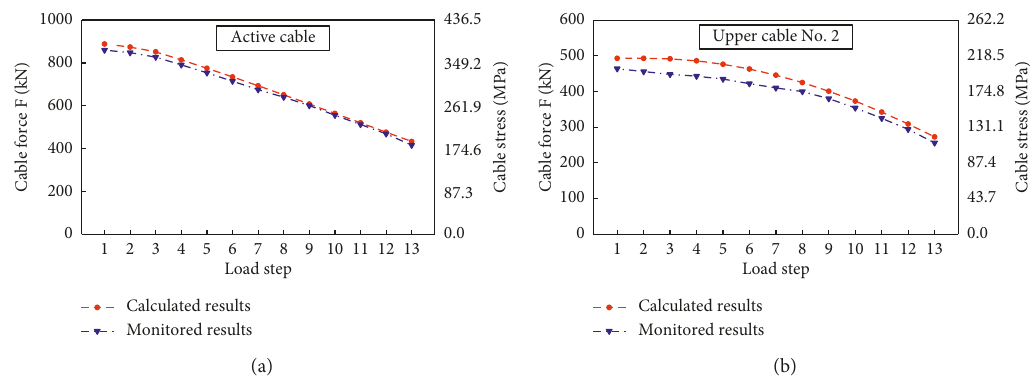
Figure 14: Comparison of calculated and monitored results of cable force. (a) Active cable. (b) Upper cable No.